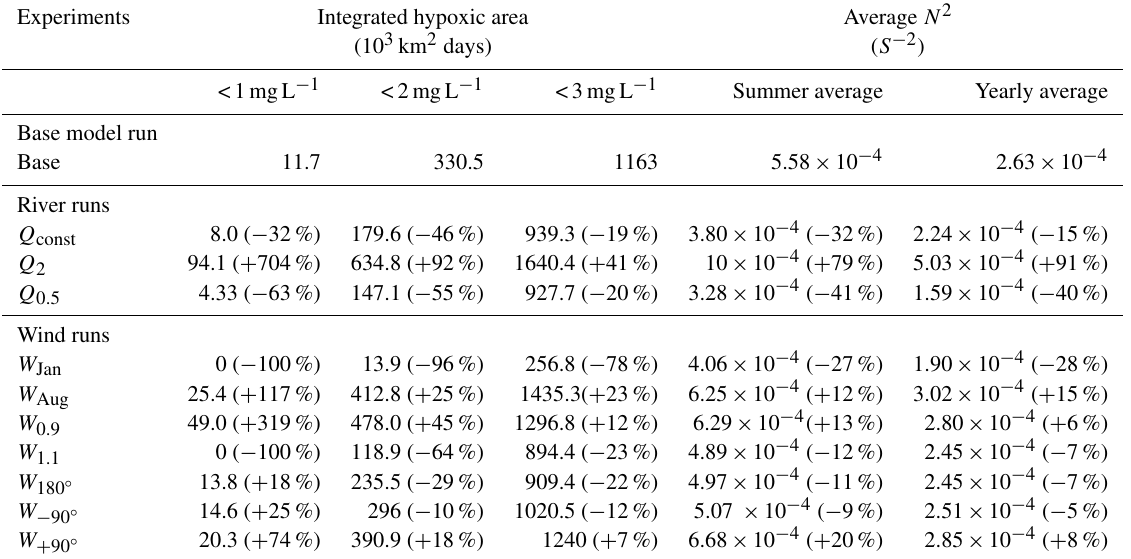
Table 2. The total area of hypoxic area under different thresholds of DO, the average N 2 in summer, and the year.